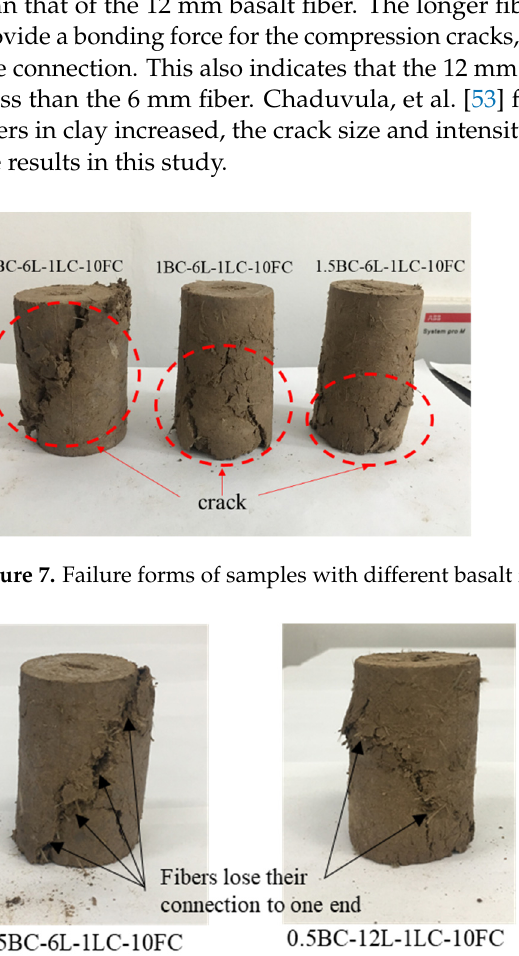
( d ) Figure 6. Effects of basalt fiber and lime on UCS under different freeze–thaw cycles: ( a ) L = 6 mm and LC = 1%; ( b ) L = 6 mm and LC = of 3%; ( c ) L = 12 mm and LC = 1%; and ( d ) L = 12 mm and LC = 3%. 4.2. Effects of Basalt Fiber Content and Length From Figure 6a it can be seen that the UCS increases with the increase in basalt fiber content. For example, under the conditions of 0 freeze–thaw cycle and 1% lime content, with the content of basalt fiber with 6 mm length increasing from 0.5% to 1.5%, the UCS increased from 134 kPa to 231 kPa. This shows that the basalt fiber content has a consid- erable effect on the strength of the loess sample. The uniaxial compression failure wit-